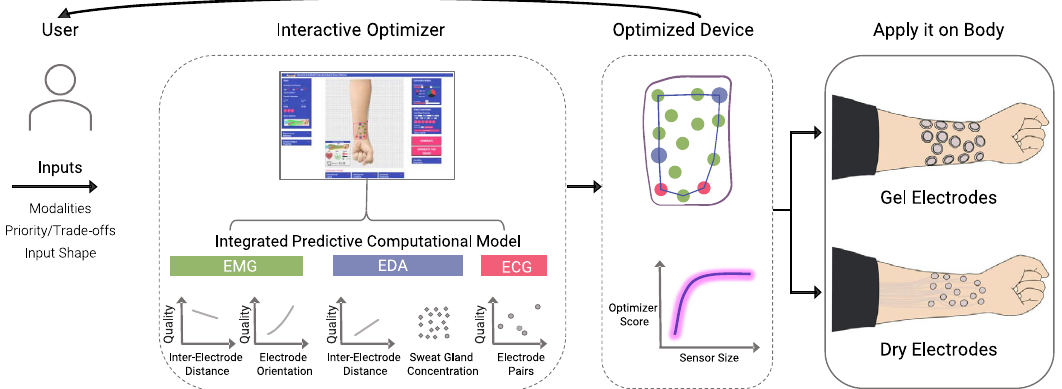
Fig. 1 Overview of the concept of computational design and optimization of electro-physiological sensors. An integrated predictive model is presented, which encapsulates three biosignal modalities (EMG, EDA, and ECG). This model along with inputs from the user are fed to an optimizer which generates an optimized layout that optimally trades-off between desired device size and sensing quality. An interactive software tool assists the user in specifying desired properties and inspecting the generated design in real-time. The design can be further fi ne-tuned by an expert while interactively inspecting its quality, allowing for a “ human-in-the-loop ” optimization process. The optimized device can then be realized using commercial gel electrodes or through dry electrodes fabricated on a temporary